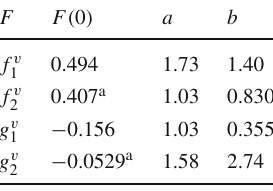
Table 7 The widths (in unit 10 10 s − 1 ) and up-down asymmetries of